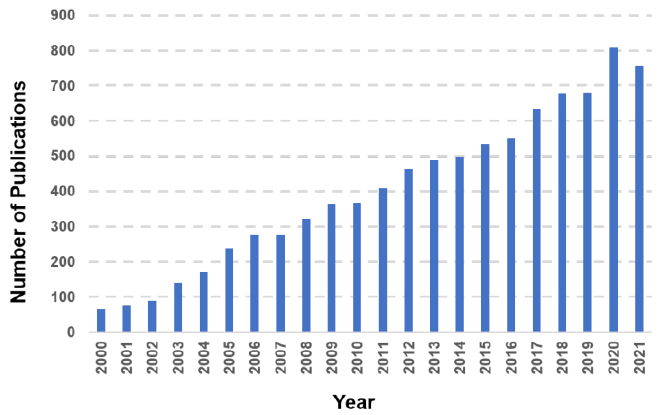
Figure 1. Articles identified on PubMed using “oxidative stress” and “cardiovascular disease” as keywords from 2000 to 2021.